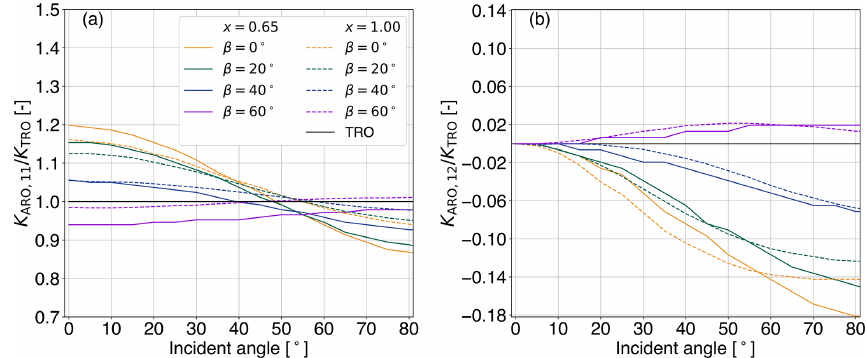
Figure 1. For large plate aggregate, the extinction matrix elements of azimuth random orientation (ARO) normalized by the extinction cross section in the case of total random orientation (TRO) are shown as a function of incident angle θ inc at 166.9GHz. Results are presented for (a) K ARO , 11 /K TRO and (b) K ARO , 12 /K TRO for two size parameters ( x = 0 . 65, solid lines, and x = 1 . 00, dashed lines) and four tilt angles ( β ) highlighted using different colors. The values for TRO are depicted in